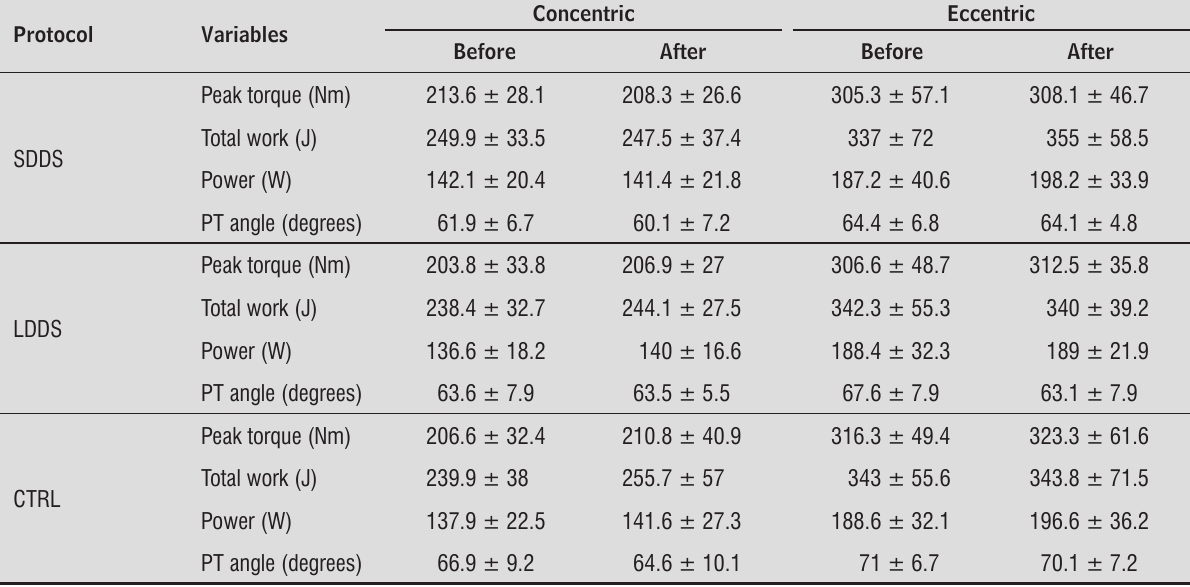
Table 1 - Results corresponding to knee extensors at 60º/s